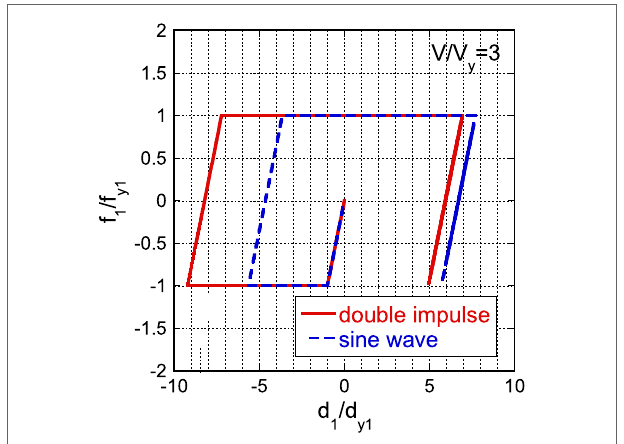
FigUre a3 | comparison of first-story restoring-force characteristic under the double impulse and the corresponding sinusoidal